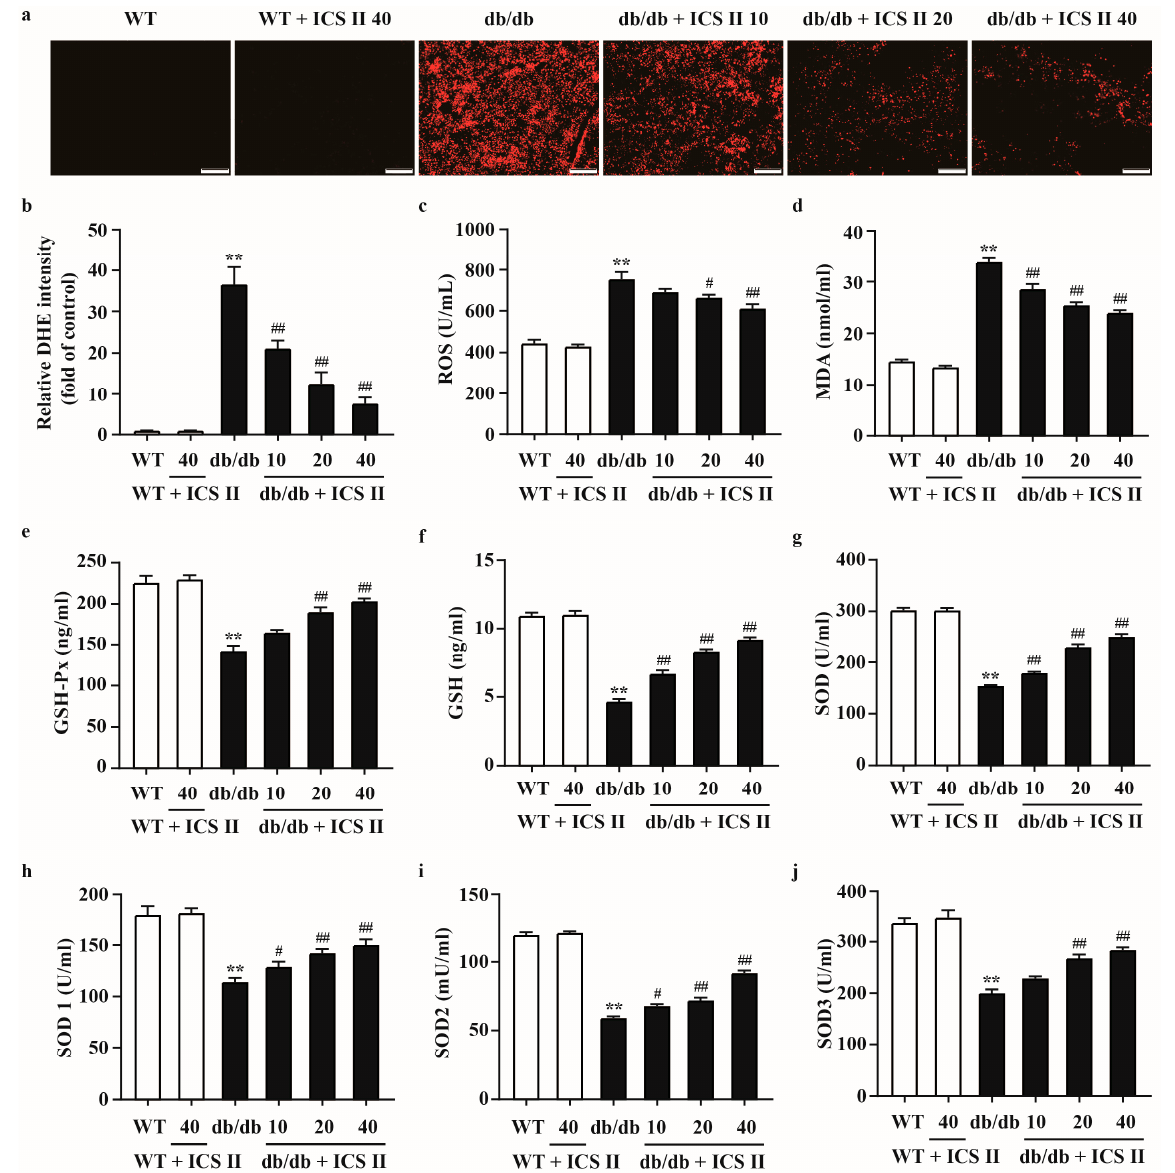
Figure 4. The effect of ICS II on oxidative injury in liver of db/db mice. ( a ) Representative DHE staining in the liver ( × 100, scale bar = 200 µ m). ( b ) Quantitation of DHE staining. After the calculation of intensity per image, the signal intensity was divided by the captured area and expressed as folds of WT group ( n = 5). ( c ) ROS level ( n = 8). ( d ) MDA level ( n = 8). ( e ) GSH-Px activity ( n = 8). ( f ) GSH activity ( n = 8). ( g ) SOD activity ( n = 8). ( h ) SOD1 activity ( n = 8). ( i ) SOD2 activity ( n = 8). ( j ) SOD3 activity ( n = 8). Data were expressed as mean ± SEM. ** p < 0.01 versus WT group; # p < 0.05 and ## p < 0.01 versus db/db group.